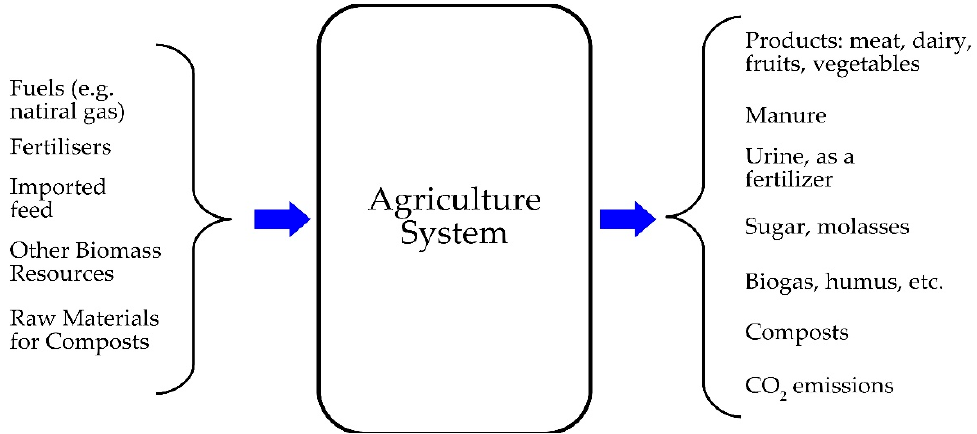
Figure 1. A multi-input–output process for an example of an agriculture system.